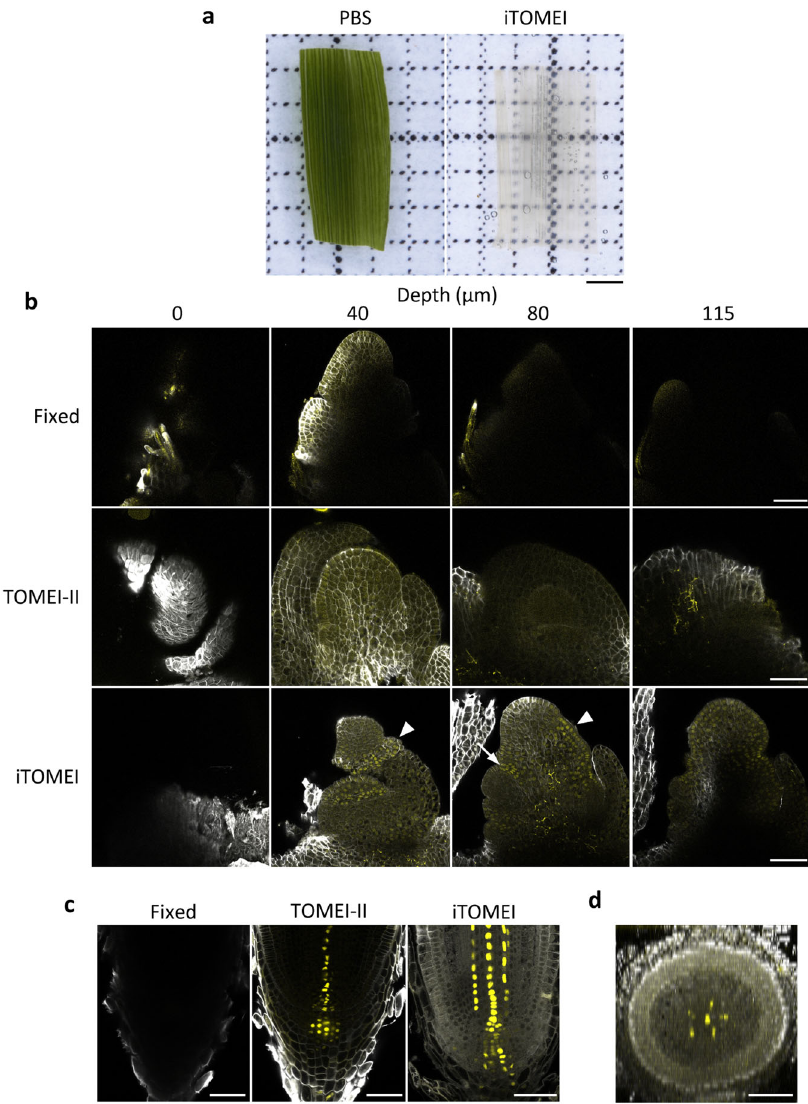
Fig. 5 Deep imaging of transparent rice organs using iTOMEI. a Leaf of 5-day-old seedling of O. sativa treated with PBS buffer and iTOMEI. b Shoot apical meristem of a plant expressing MADS15-mOrange (yellow) stained with SR2200 (white) and treated with PBS buffer, TOMEI-II, and iTOMEI. Confocal optical sections were captured under the same optical conditions. The arrow indicates a strong mOrange signal in the basal region of a hairy bract. The arrowhead indicates mOrange signal at the incipient primary branch meristem. c, d Root tip of a plant expressing DR5rev::NLS-3xVenus (yellow) stained with SR2200 (white) and treated with PBS buffer, TOMEI-II, and iTOMEI. Confocal longitudinal ( c ) and transverse optical sections ( d ) of the root are shown. Scale bars = 1 mm ( a ) and 50 µ m ( b – d